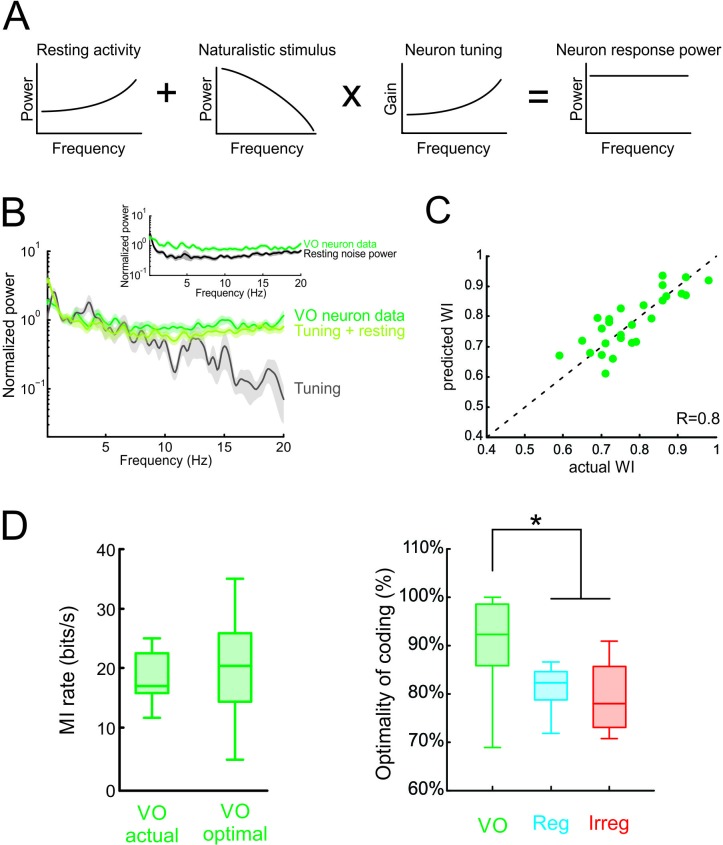
Neural variability and tuning determine whitening of natural self-motion stimuli by central vestibular neurons.(A) Schematic showing how the response power spectrum (right) can be predicted from the resting activity power spectrum (left) as well as the stimulus power spectrum (middle left) and the neural tuning function (middle right). Specifically, the resting activity power spectrum should compensate the transmitted power spectrum (i.e. that obtained by multiplying the stimulus power by the tuning function) such that the response power spectrum (i.e., the sum of the two) is constant as a function of frequency. (B) Population-averaged actual response power spectrum (dark green) together with the prediction from the resting discharge and tuning (light green). The transmitted power spectrum (grey) is also shown. The inset shows the population-averaged resting discharge (black) and actual response (dark green) power spectra. (C) Predicted versus actual whitening index values for central vestibular neurons. Data points were scattered across the identity line. (D) Left: Population-averaged actual (left) and maximum (right) information rate values for central vestibular neurons. Right: The population-averaged mutual information normalized by the optimal value for VO neurons (green) was significantly greater than that of regular (blue) and irregular (red) afferents (one-way ANOVA, p < 0.001, F(2,50)=14.79). Error bars represent ±1 SEM.